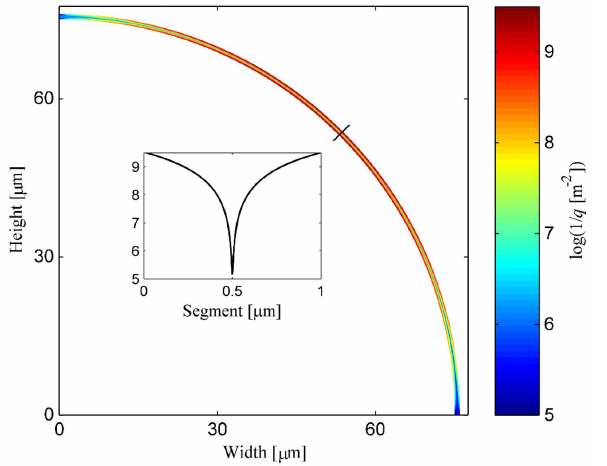
Figure 12. Zoom-in of the top right quadrant of the model shown in Fig. 7 showing the local attenuation (1 /q ) for a grain diameter d = 150µm and a water film thickness a = 1µm, at the characteristic frequency. This field corresponds to those shown in Figs. 10 and 11. The inset illustrates the profile across the interfacial film where it is crossed by a black line.